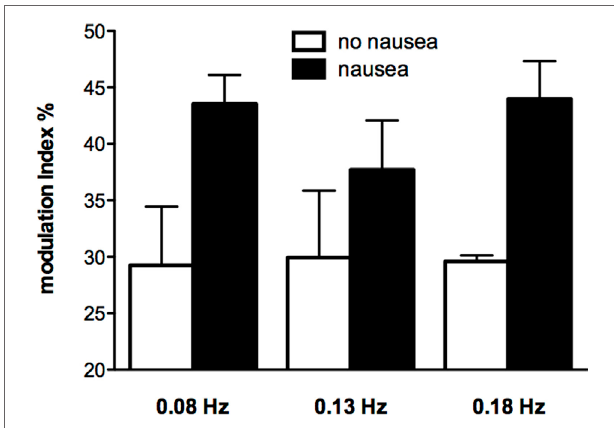
FiGURe 5 | Modulation indices of primary peak of skin sympathetic nerve activity during sinusoidal GVS at different frequencies as a function of whether or not subjects reported nausea. It can be seen that modulation indices were higher in those subjects who reported nausea. Reproduced with permission from Hammam et al.